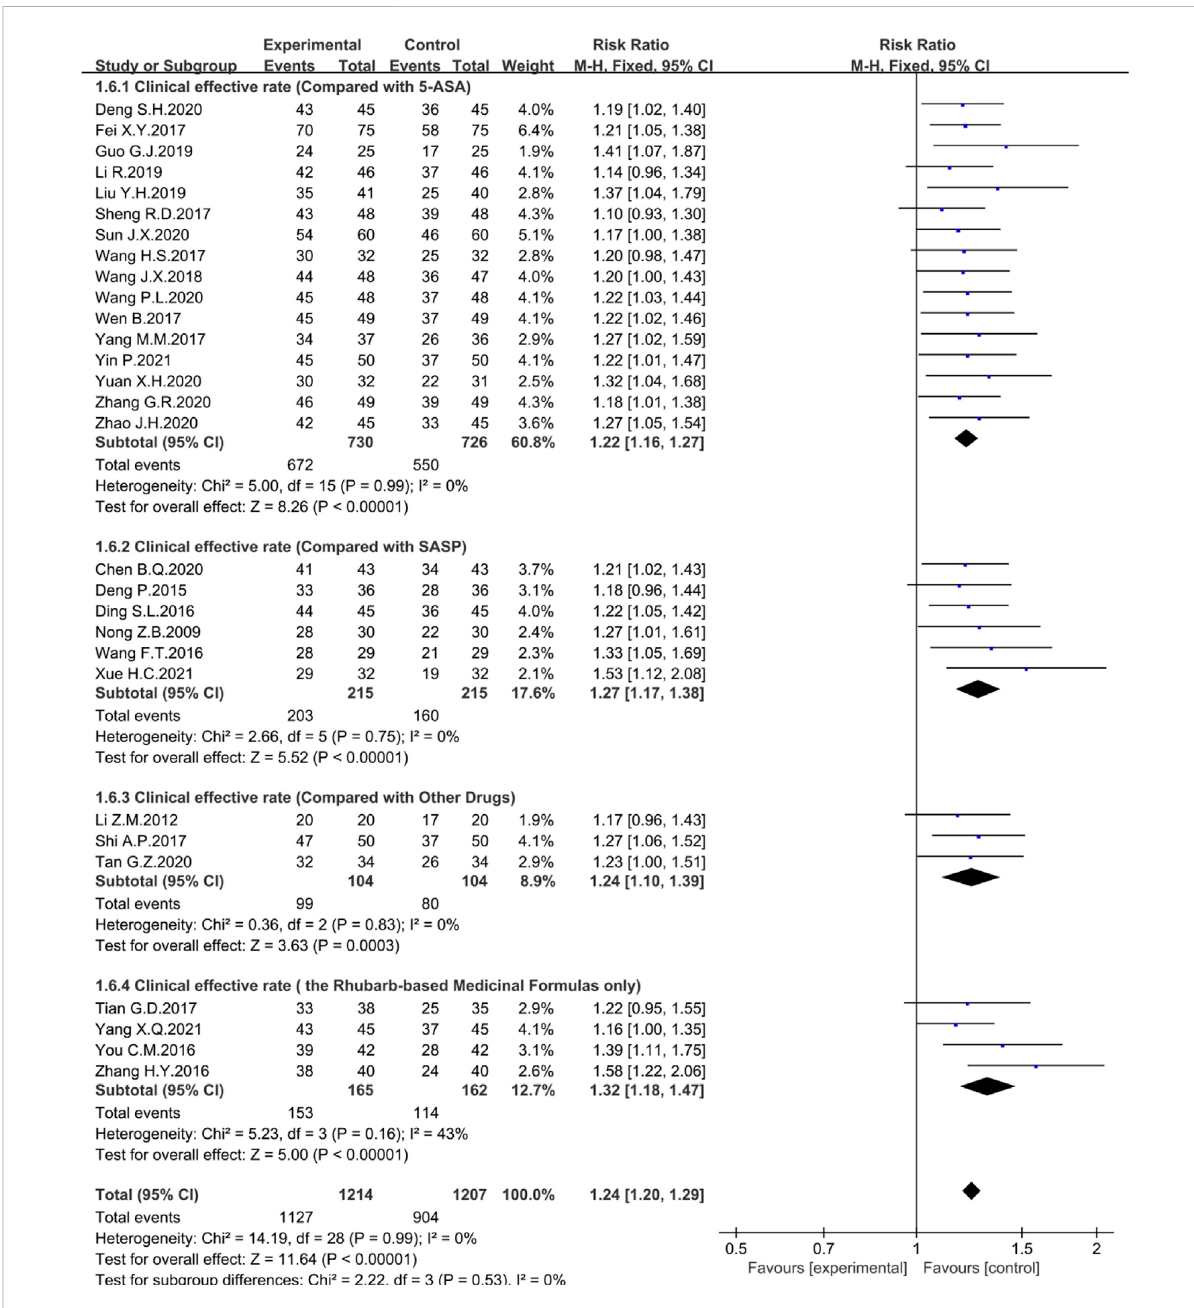
FIGURE 4 Forest plot displaying the results of the Meta-analysis for clinical ef fi ciency in the rhubarb-based medicinal formulas alone or combined with other drugs.